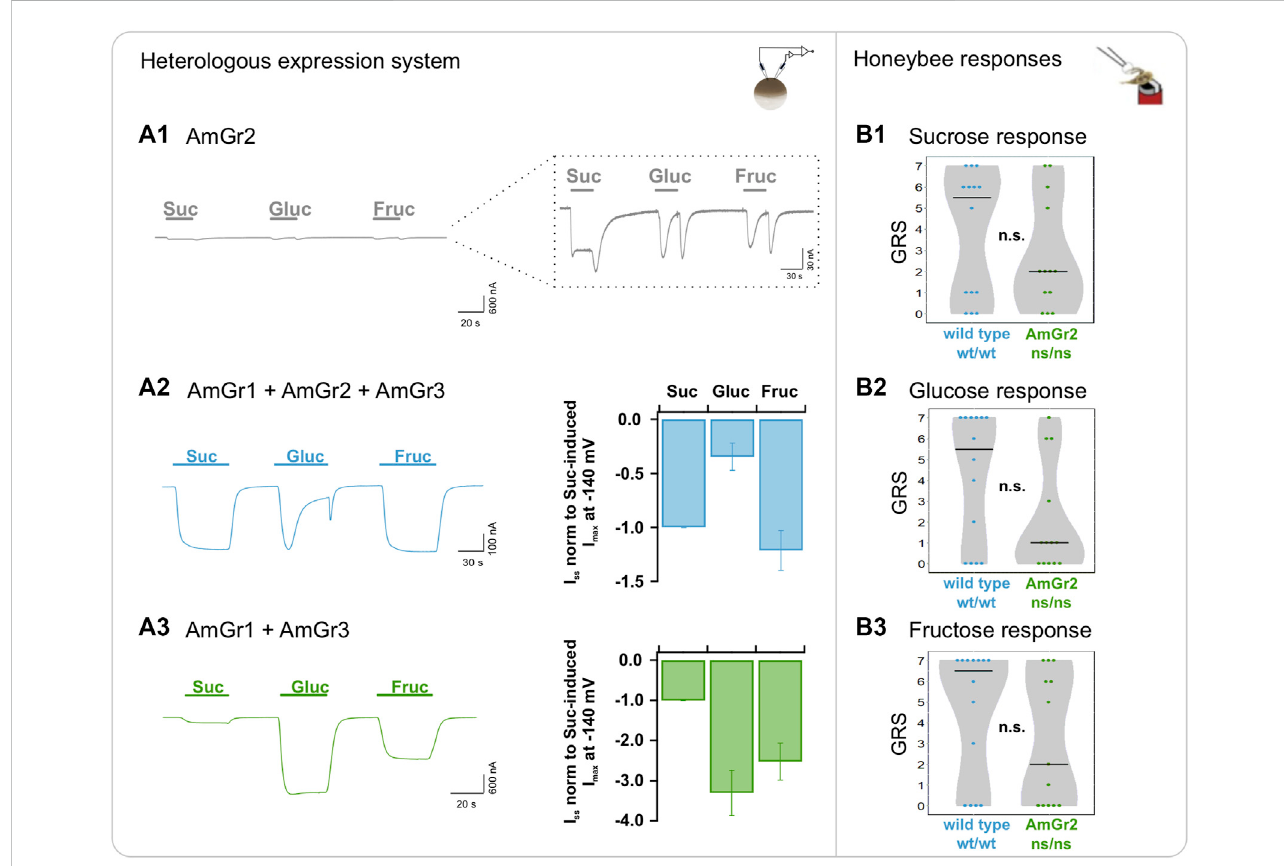
FIGURE 2 Functional analysis of A. mellifera gustatory receptor AmGr2 using a matched heterologous expression system and in vivo comparative approach. (A1 – A3) : two-electrode voltage clamp measurements: Current traces were recorded at a holding potential of − 80 mV in response to perfusion with sucrose (Suc), glucose (Gluc) and fructose (Fruc) in standard solution (left panel). Sugar-induced I SS were recorded at a membrane potential of − 140 mV and normalized to the currents in sucrose solution (middle panel). (A1) Representative whole oocyte current trace of AmGr2-expressing oocyte. Inset: Magni fi cation of the current trace reveals microscopic sustained or transient inward currents upon sugar application. (A2) Control (for clari fi cation displayed again): The inward whole oocyte currents from AmGr1/AmGr2/AmGr3-expressing oocyte (wild type mimicry, left panel); Quanti fi cation of sugar-induced I SS that were normalized to sucrose-evoked I SS at − 140 mV (mean of n = 10 oocytes ± SD; middle panel). These same values are displayed in all fi gures as consistent control. (A3) Whole oocyte currents from AmGr1/AmGr3 co-expressing oocyte (left panel); Currents are normalized to the sucrose-evoked I SS at − 140 mV(meanof n =13oocytes±SD;middlepanel). (B1 – B3) :behaviouralevaluationthroughproboscis extensionresponse (PER, invivo ).Wild-type(wt/ wt, N = 14) and AmGr2 mutant bees (ns/ns; N = 13) were presented a series of sugar concentrations (16%, 20%, 25%, 32%, 40%, 50% and 63% ( w/v ); representing .47 M, .58 M, .73 M, .93 M, 1.17 M, 1.46 M and 1.84 M) of all three sugars sucrose (B1) , glucose (B2) and fructose (B3) . The sum of the responses (PERs) towards the concentrations of one of the sugars was recorded as a sugar-speci fi c GRS (gustatory response score) of each respective bee. The distribution of all GRS values of all measured bees is shown as data points and the resulting medians as lines. AmGr2 mutants (ns/ns) did not show any signi fi cant differences in their responsiveness towards all three sugars when compared to wild-type (wt/wt) bees, neither to sucrose (B1) ; Mann-Whitney-U, ns/ns vs. wt/wt, p = .5351, n.s.), to glucose (B2) ; Mann-Whitney-U, ns/ns vs. wt/wt, p = .0909, n.s.) or to fructose (B3) ; Mann-Whitney-U, ns/ns vs. wt/wt, p = .2536,